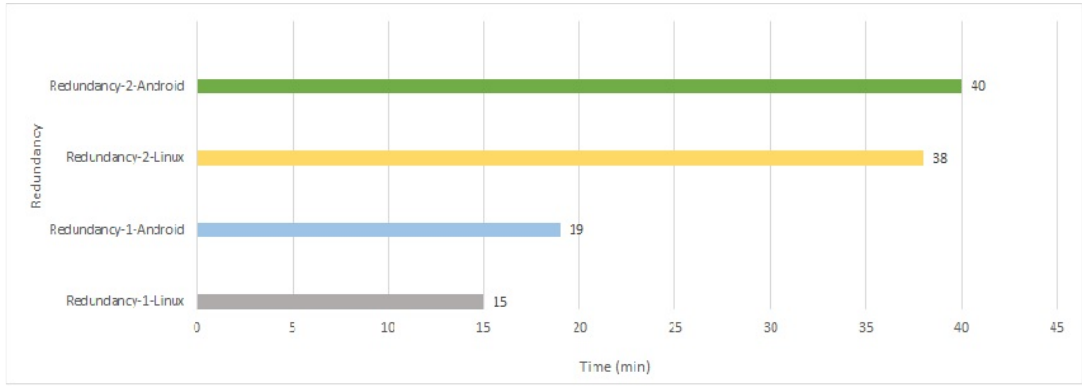
Figure 8: Impact of the redundancy